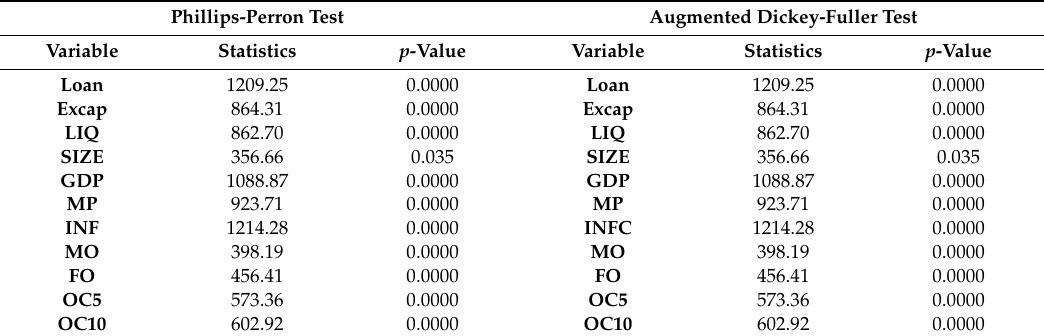
Table A5. Panel Unit-root Test: Fisher-type unit-root test